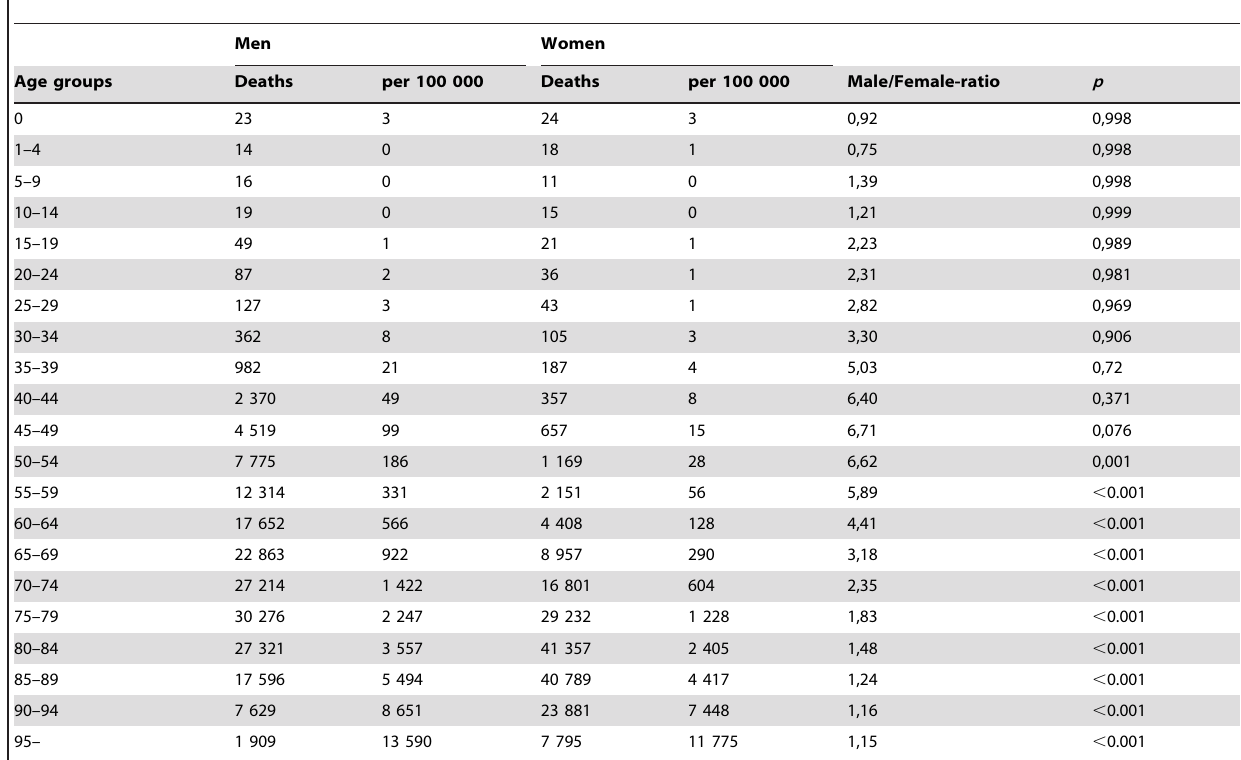
Table 3. Mortality from cardiovascular diseases among men and women by age, Finland